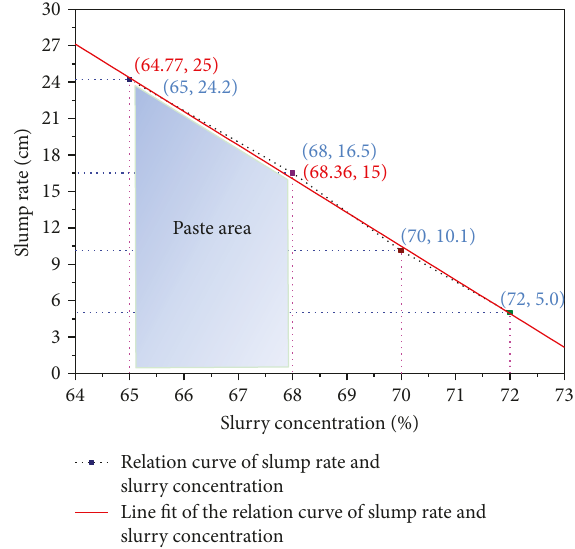
Line fit of the relation curve of slump rate and slurry Figure 10: Relation curve of the slump and PGBS